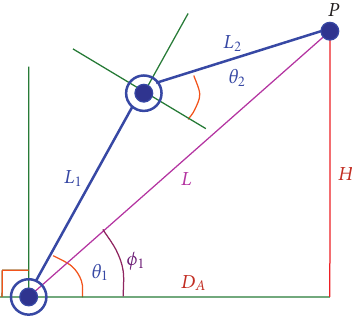
Figure 7: Simplified system